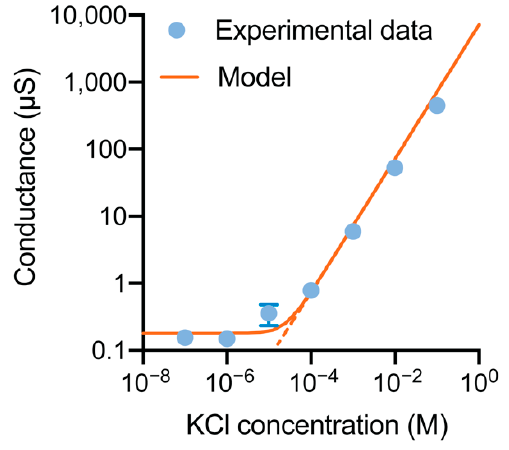
Figure 4. Measured (points) and calculated (curve) ionic conductance across the nanochannels versus the electrolyte concentration. The dashed line represents the bulk prediction, which deviates from the experimental data in the low ionic concentration region. The standard deviation of the measurements was calculated based on three membranes, tested three times each.